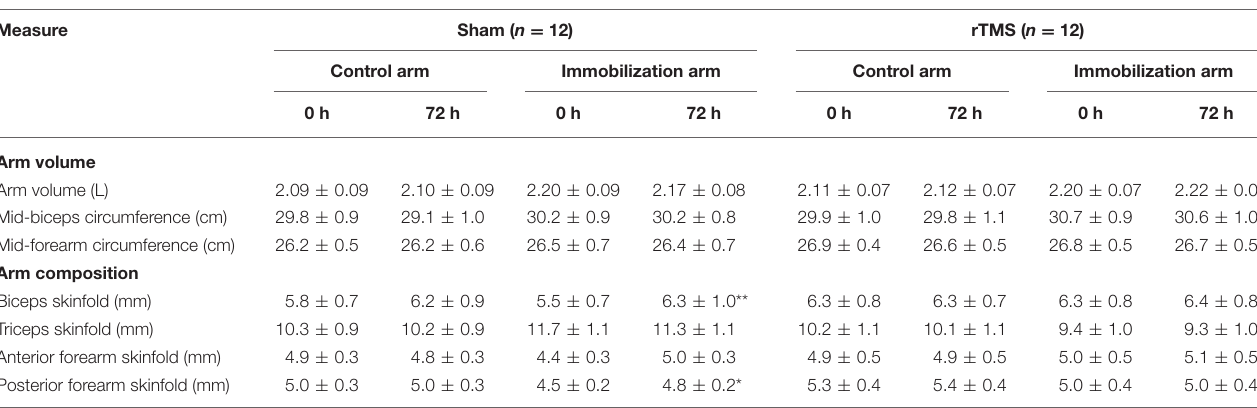
TABLE 2 | Effect of rTMS on arm composition with